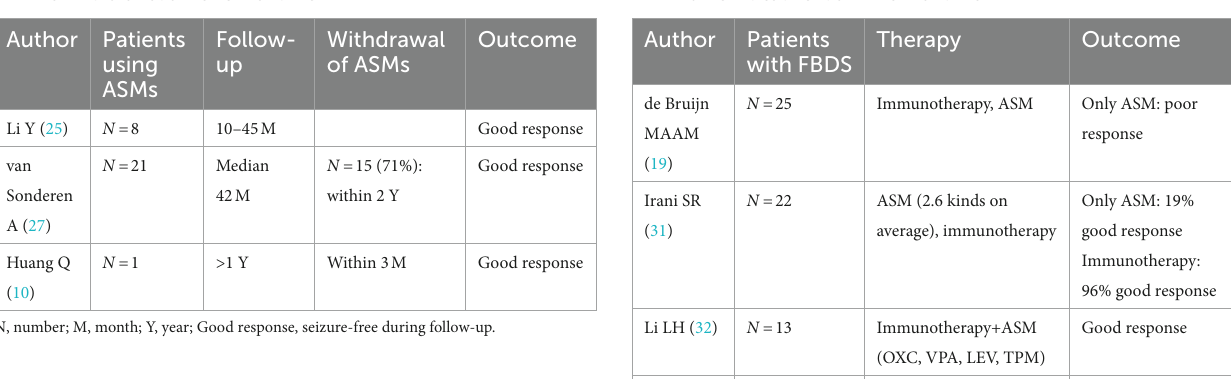
TABLE 5 Withdrawal of ASMs in anti-LGI1 AE. TABLE 6 ASM treatment of FBDS in anti-LGI1